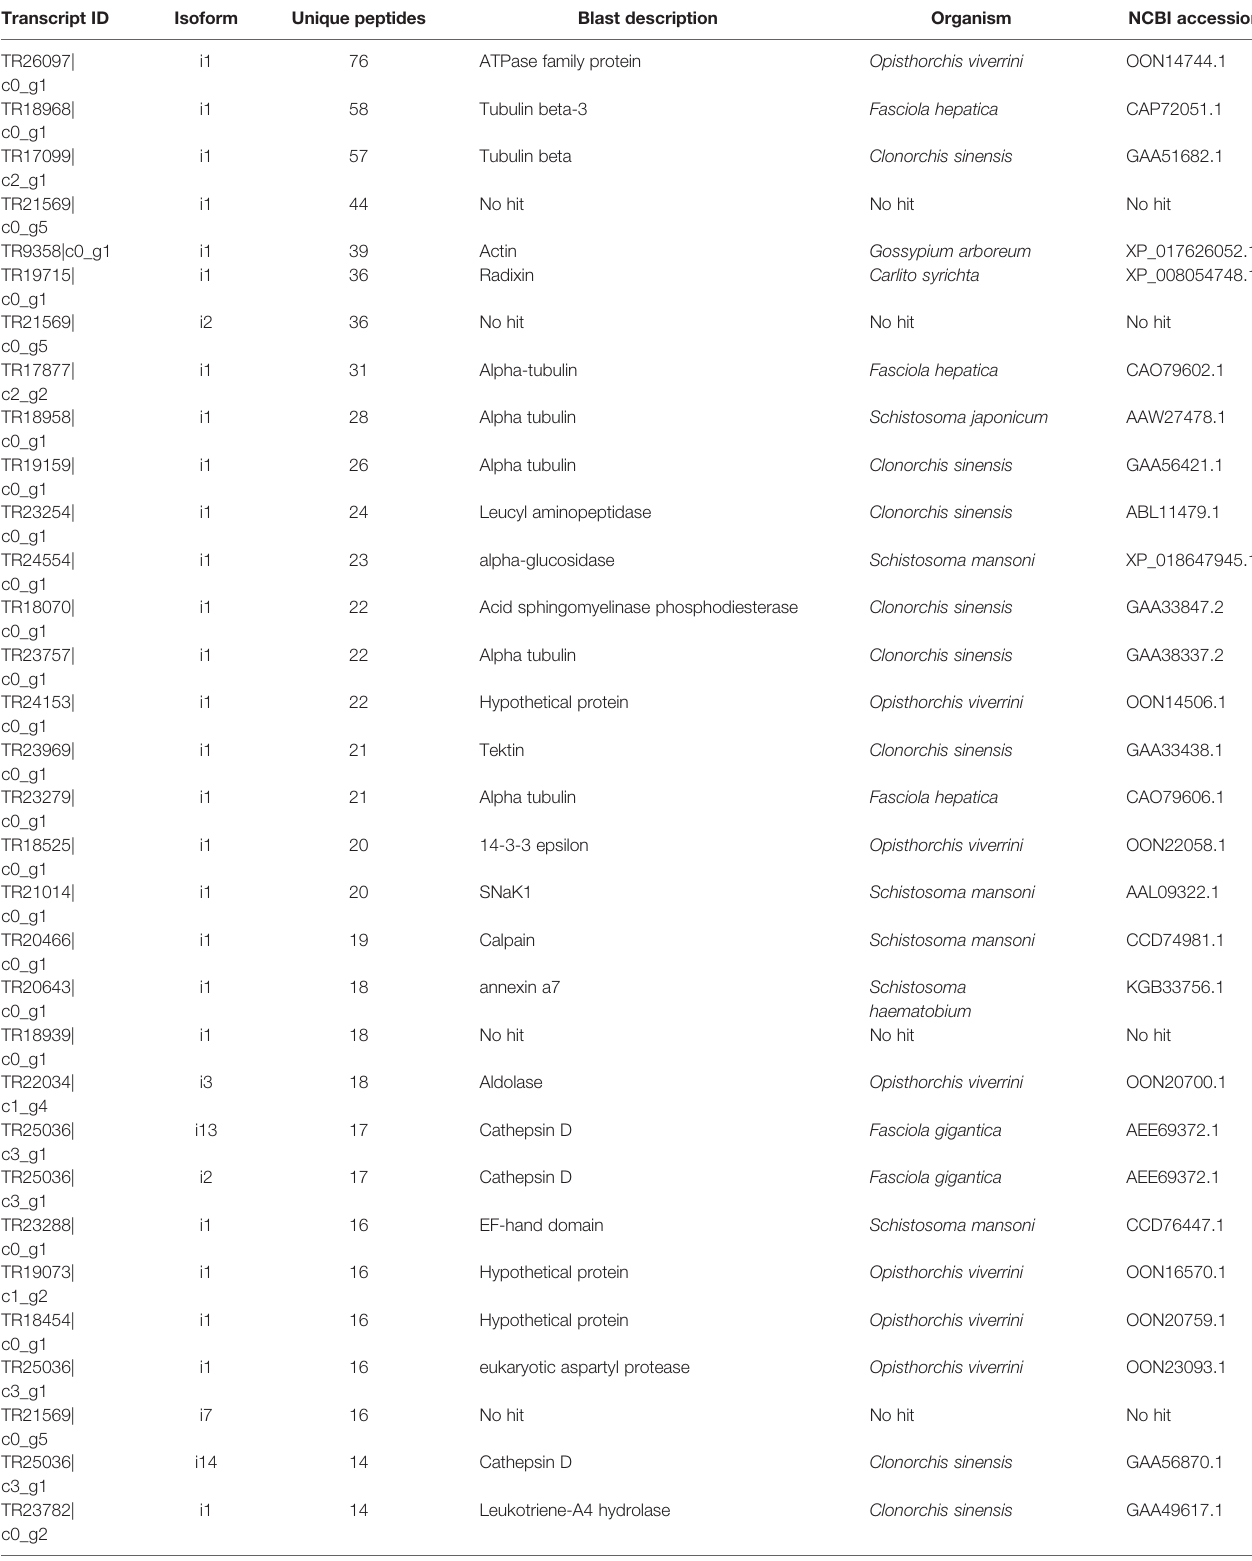
TABLE 2 | Top 50 proteins resolved in C. daubneyi extracellular vesicles following BLAST analysis of transcript identi fi